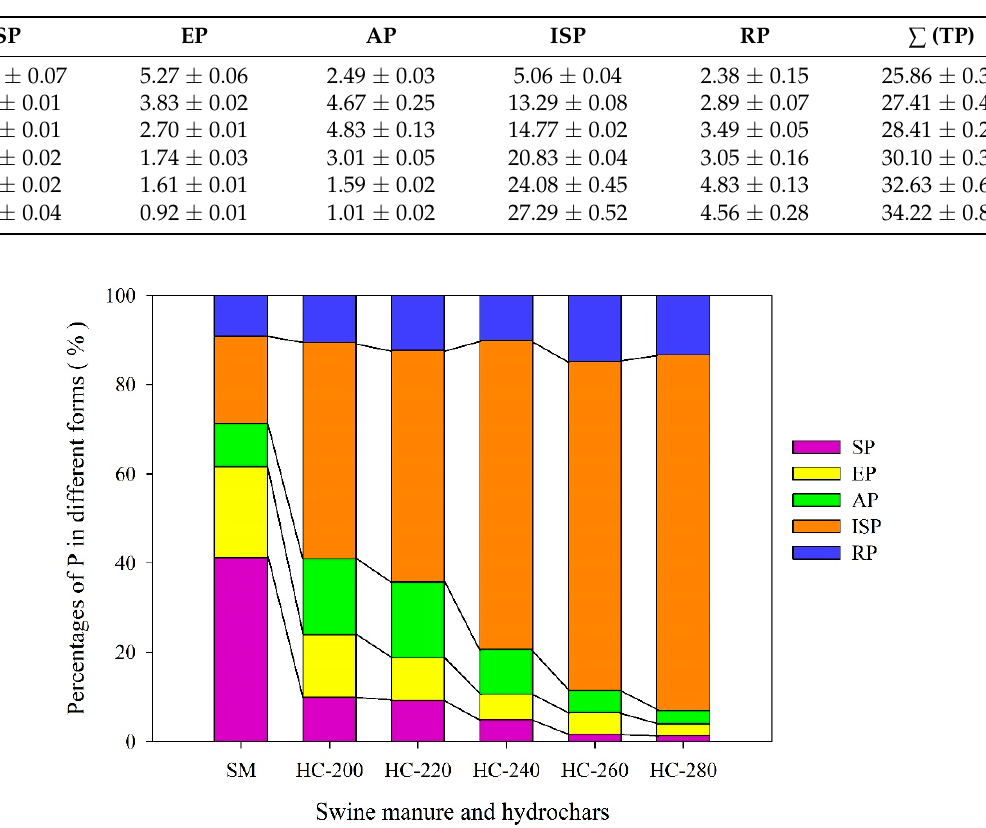
Table 2. Different forms of phosphorus in raw SM and hydrochars obtained at different reaction temperatures (mg/g, dry basis).